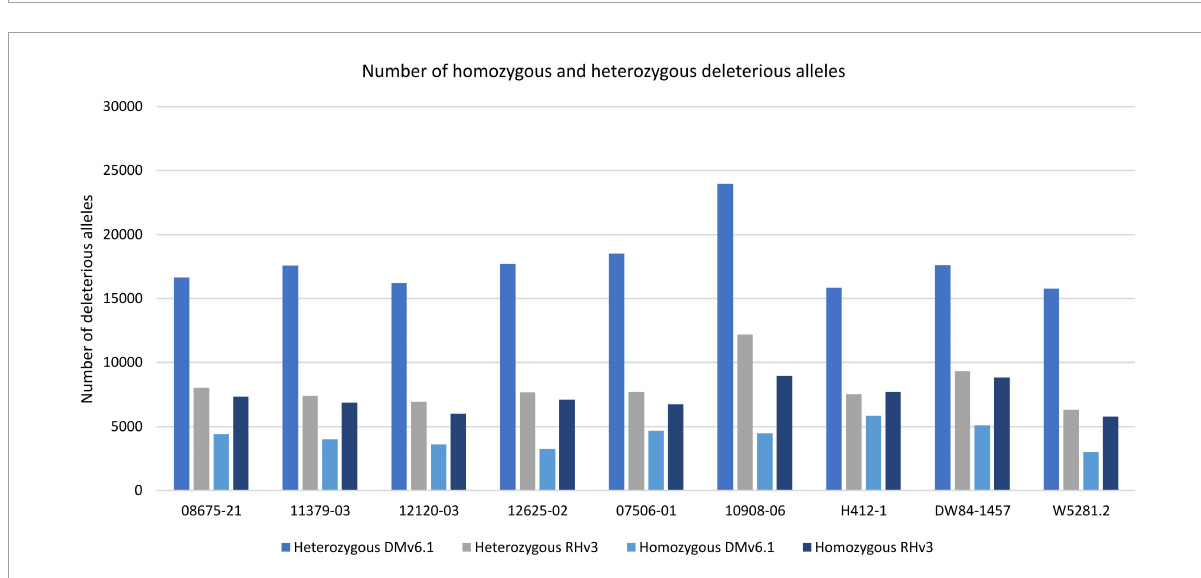
FIGURE4 Number of homozygous and heterozygous deleterious alleles in each genome against DMv6.1 and RHv3.